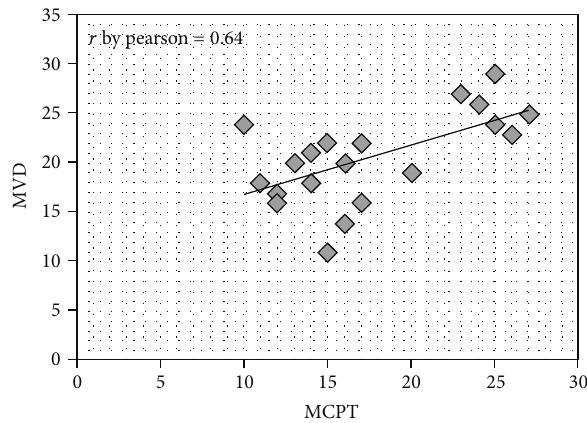
Figure 2: Pearson distribution of correlation between MCPT and MVD 𝑟 = 0.64 .